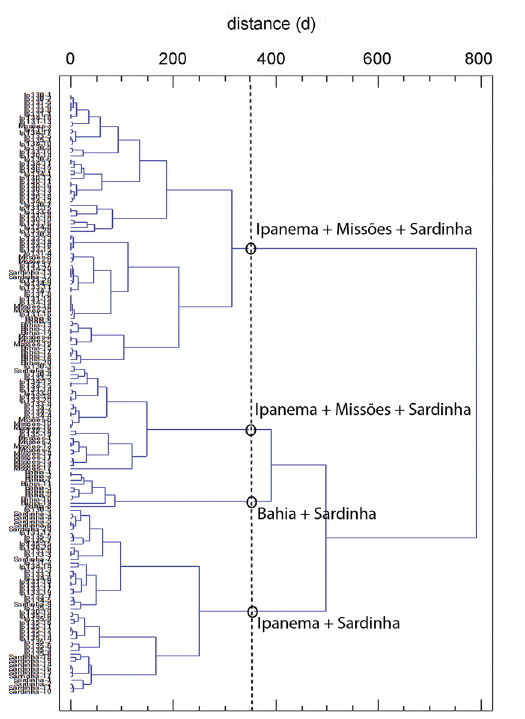
Figure 5: Dendrogram using the treated EDX results of the “matrix” of the slag inclusions.